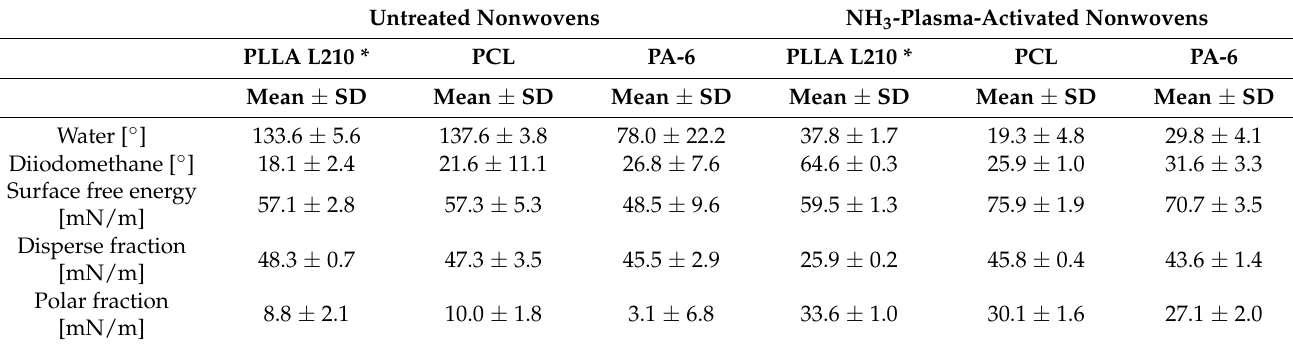
Table 1. Summary of wettability and surface free energy of untreated and NH 3 -plasma functionalized PLLA L210, PCL and PA-6 nonwovens. MSA measurement after 2 s, n = 3.